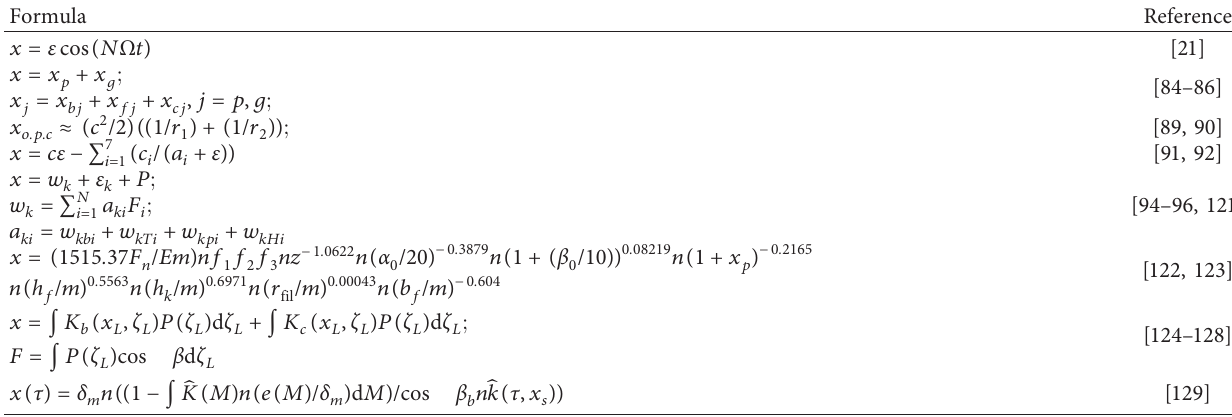
Table 1: Formulae for transmission error